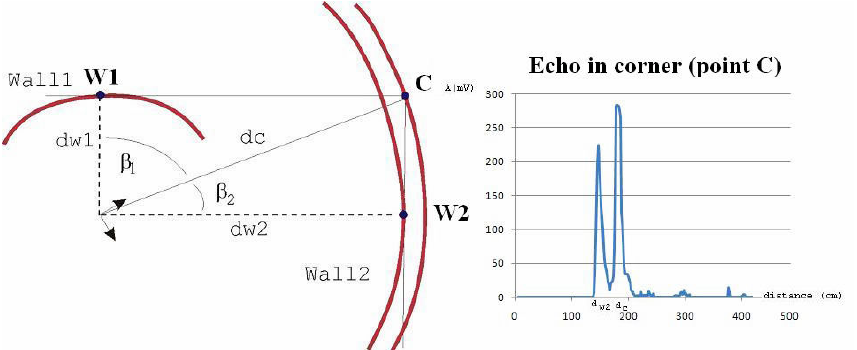
is bigger than 55 ◦ . The echo in 1 < 55 ◦ ). ( β 2 2